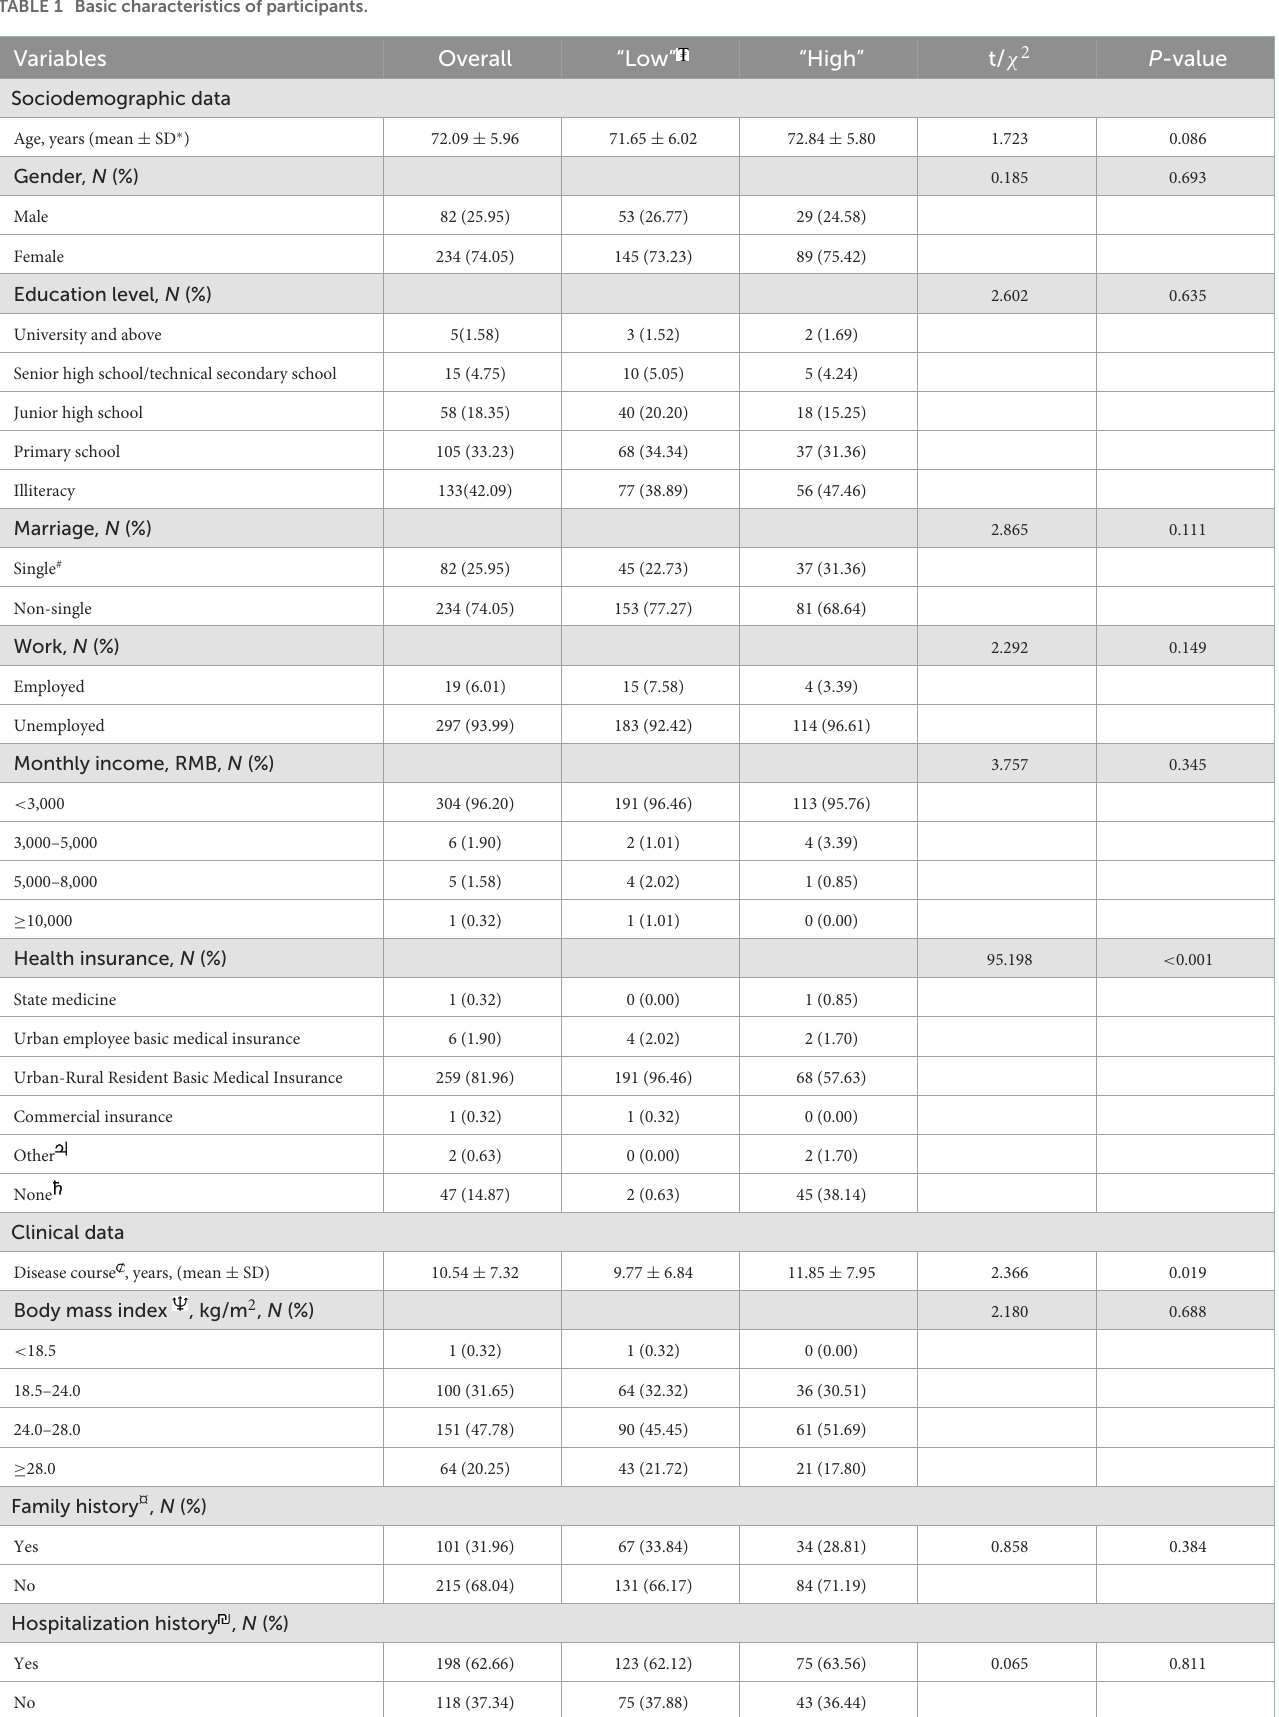
TABLE 1 Basic characteristics of